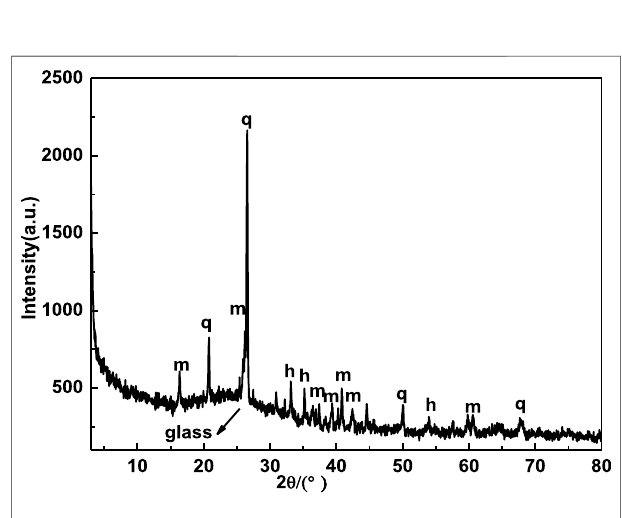
FIGURE 1 | XRD spectra of coal fl y ash (q, quartz; m, mullite; h,